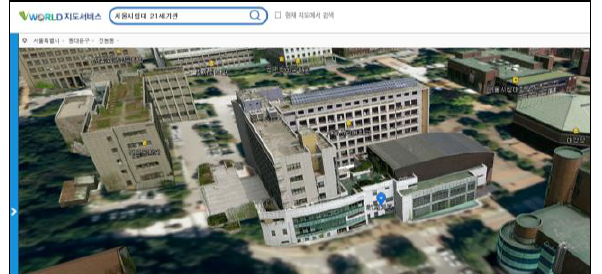
Figure 3. Example of the aspect of Visualization(V-world, 2017)